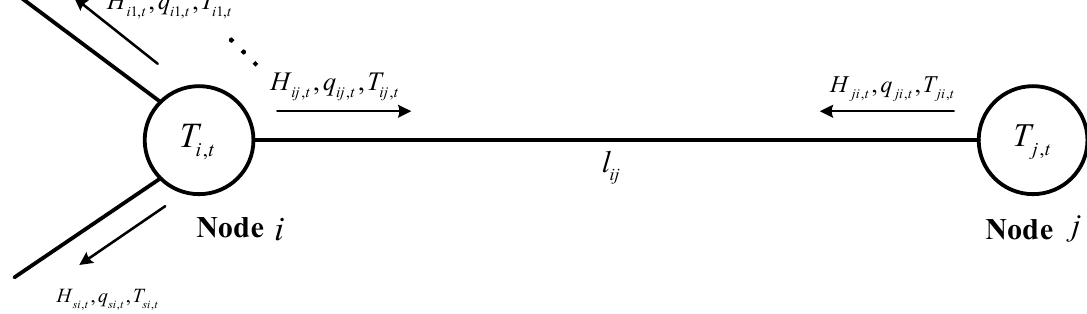
Figure 2. General energy transfer model of the heating network.